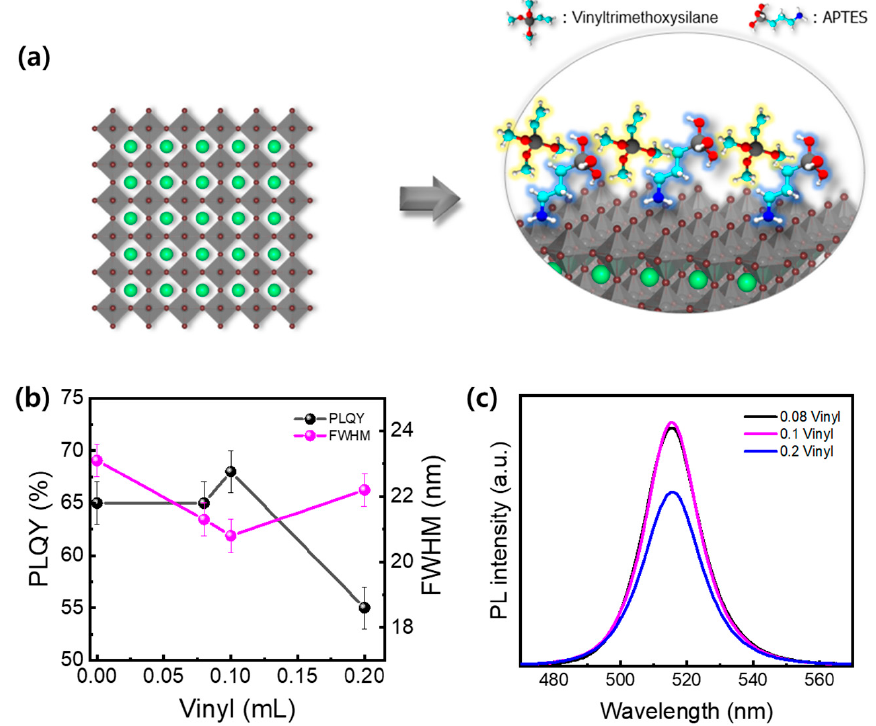
Figure 2. ( a ) Schematic illustration of two-time cross-linkable core-shell perovskite NCs. ( b ) The PLQY and FWHM of PL peak, and ( c ) PL spectra for core-shell perovskite/SiO 2 synthesized with different amount of vinyltrimethoxysilane.